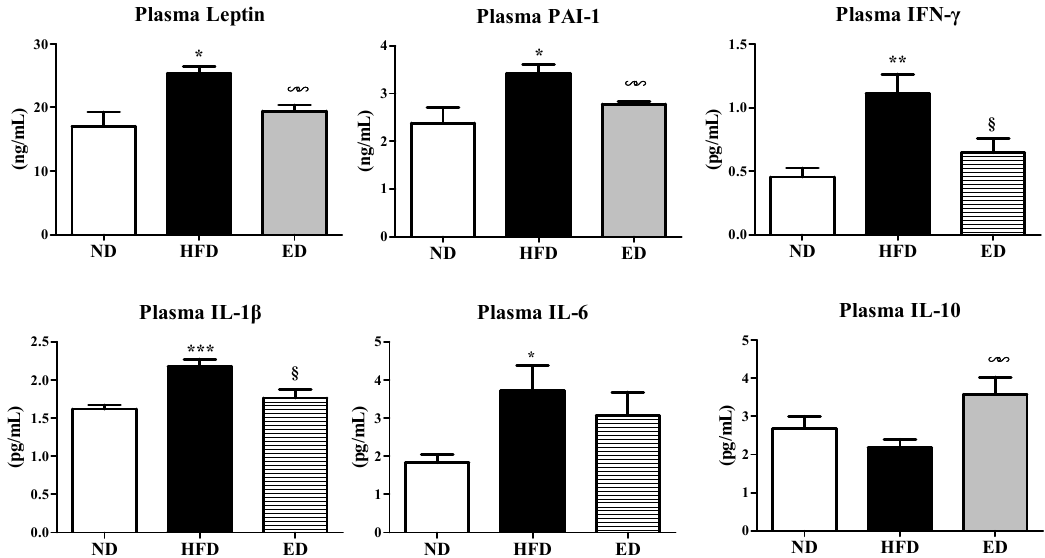
Figure 5. Effect of eriodictyol treatment on the plasma adipokine and cytokine levels in C57BL/6N mice fed with the high-fat diet (HFD). Data are presented as means ± SEM. Normal diet (ND; AIN-76) vs. HFD; * p < 0.05, ** p <0.01, *** p < 0.001. HFD vs. ED (HFD + 0.005% ED); § p < 0.05, §§ p < 0.01. PAI-1, plasminogen activator inhibitor-1; IFN- γ , interferon-gamma; IL,